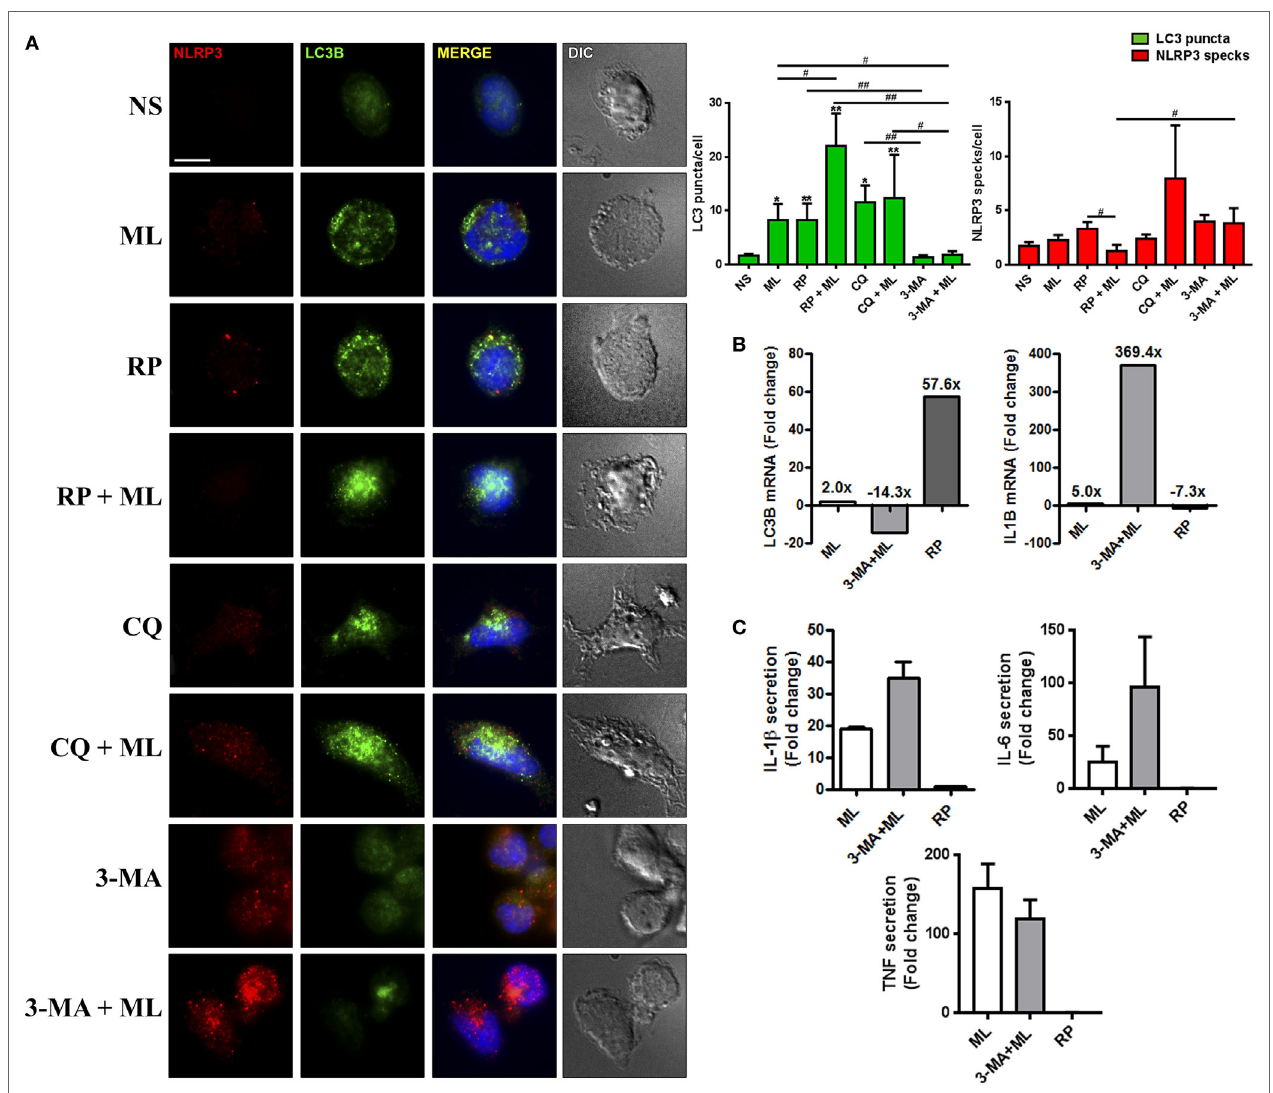
FigUre 5 | Autophagic pathway regulates inflammasome activation in blood-derived monocytes stimulated with M. leprae . (a–c) Monocytes were purified from healthy donors’ peripheral blood mononuclear cells by 2-h adherence and stimulated with 10 µg/mL M. leprae (ML) in the presence or absence of autophagy regulators for 18 h. Autophagy was triggered with 200 ng/mL rapamycin (RP), and inhibited with 100 µM chloroquine (CQ, autophagic flux blocker) and 10 µM 3-methyladenine (3-MA). (a) Monocytes stimulated with M. leprae , RP, CQ, and 3-MA were fixed and stained with anti-NLRP3 (red), anti-LC3B (green) antibodies and DAPI (blue). Monocytes stimulated with M. leprae increase the number of LC3-II-decorated autophagosomes (puncta) per cell, which is reforced by RP addition, and reverted by 3-MA. Autophagy blocking with CQ and 3-MA was able to increase NLRP3 specks numbers per cell in relation to the well stimulated with M. leprae and RP. Immunofluorescence images were quantified and bars represent the mean values of the number of LC3 puncta and NLRP3 specks per cell ± SEM ( n = 3). *(in relation to NS) or # (indicated by the dashes) p < 0.05. Scale bar: 10 µm. (b) Purified mRNAs from monocyte cultures stimulated with M. leprae , the autophagy blocker 3-MA, and RP, as a control of autophagy activation, were analyzed by RT-qPCR for LC3B and IL1B . Bars represent the mean of the fold change values in relation to the non-stimulated controls of three independent experiments with similar results. (c) The IL-1 β , IL-6, and TNF levels in the monocyte cultures supernatants were assessed by ELISA. Bars represent the fold change values in relation to the non-stimulated controls ± SEM ( n =